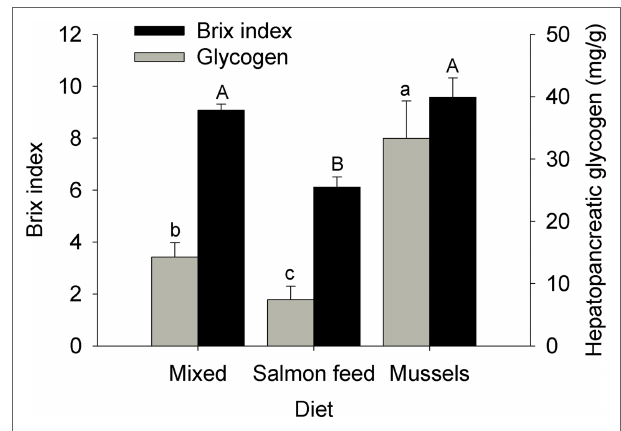
FIGURE 6 | Impact of experimental diets on concentration of hemolymph dissolved compounds (Brix index) and hepatopancreatic glycogen in the rock crab Cancer irroratus . Replicates are the mean values for each experimental tank. Log-transformed glycogen content was analyzed, but raw data is presented. Bars show mean +SE and columns not sharing a common letter are significantly different (Tukey HSD post-hoc tests, n = 5-9). The total number of individuals included in the analyses was 23, 11, and 13 for the mixed, salmonid feed and mussel diets, respectively.